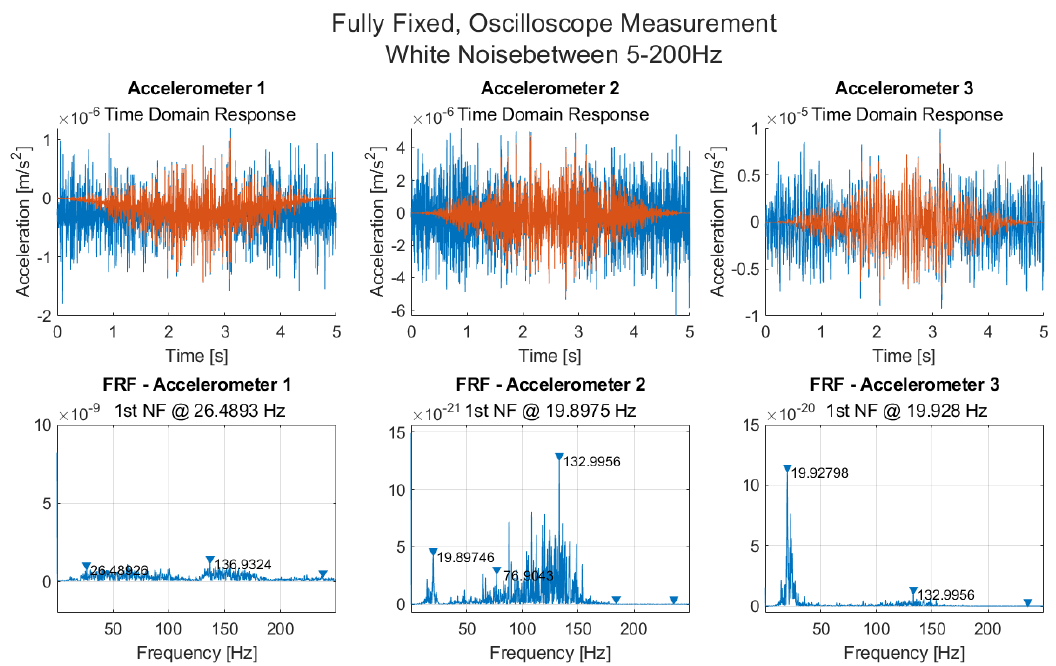
Figure 8. Time and frequency domain measurements, along with measured FRFs from accelerometers 1, 2 and 3 for white noise excitation using an oscilloscope.